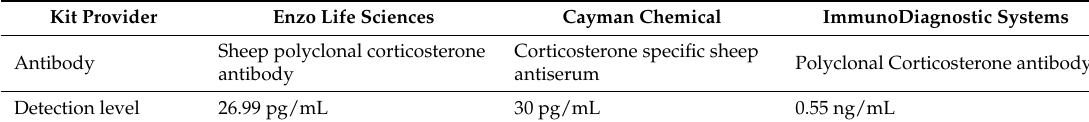
Compounds and % of